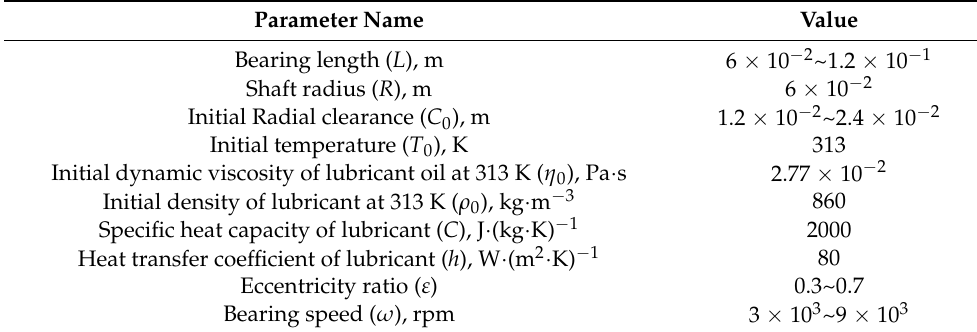
Table 1. Bearing geometric and operating parameters.